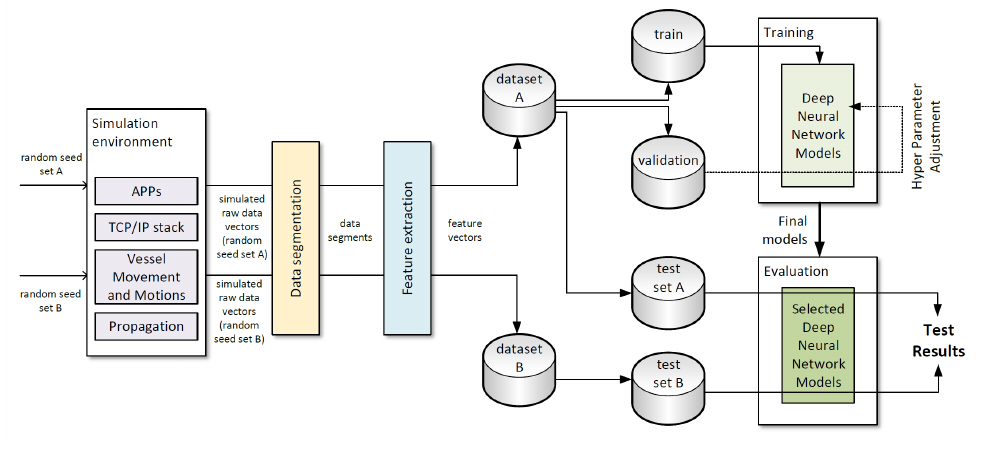
Figure 11. Experiment